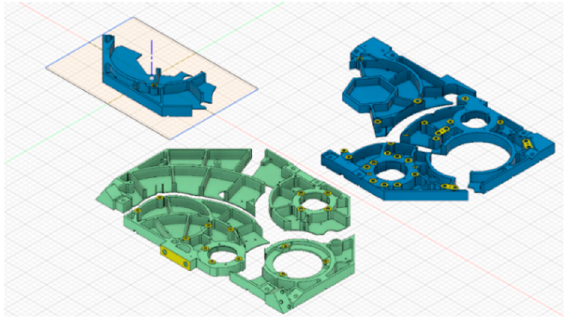
Figure 6. Piece divisions to fit in the 3D printer work area.